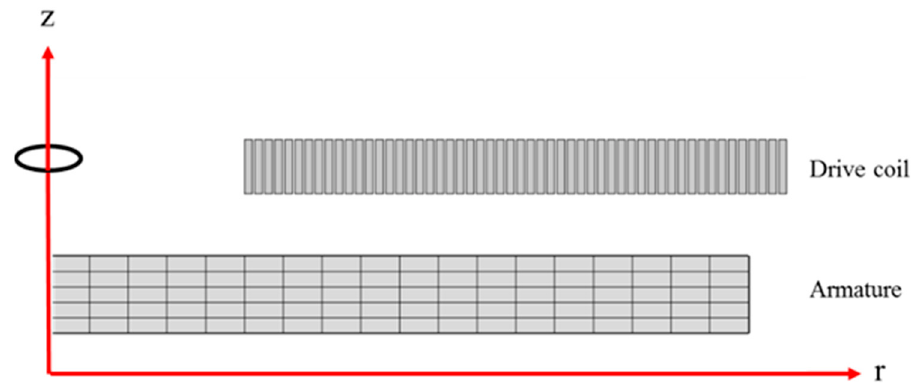
Figure A2. Partition principle of the armature.